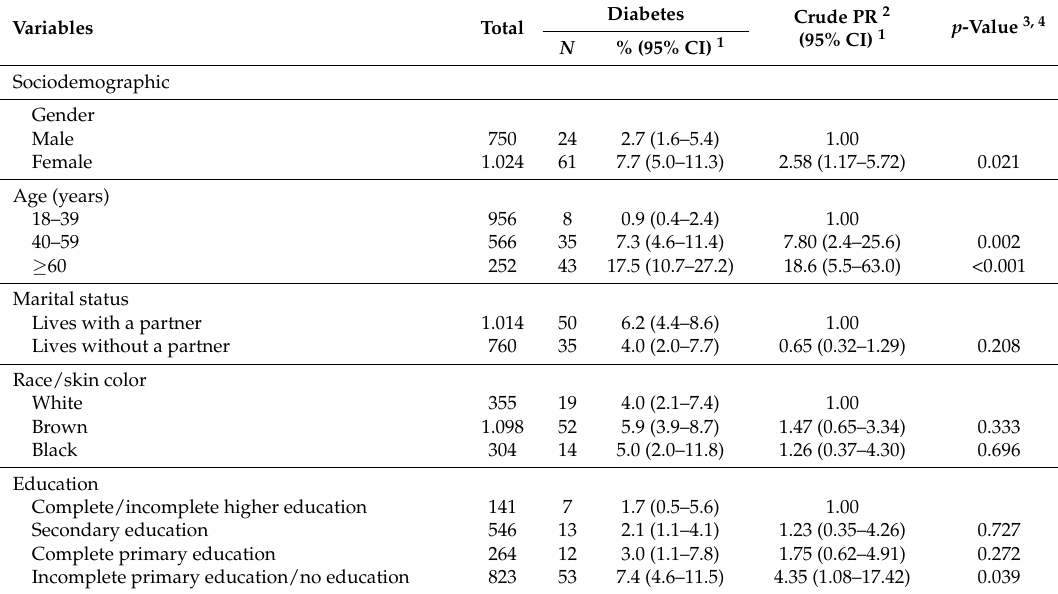
Table 1. Prevalence of diabetes mellitus (DM) according to sociodemographic variables and potential risk factors in the adult population of Maranh ã o, National Health Survey,